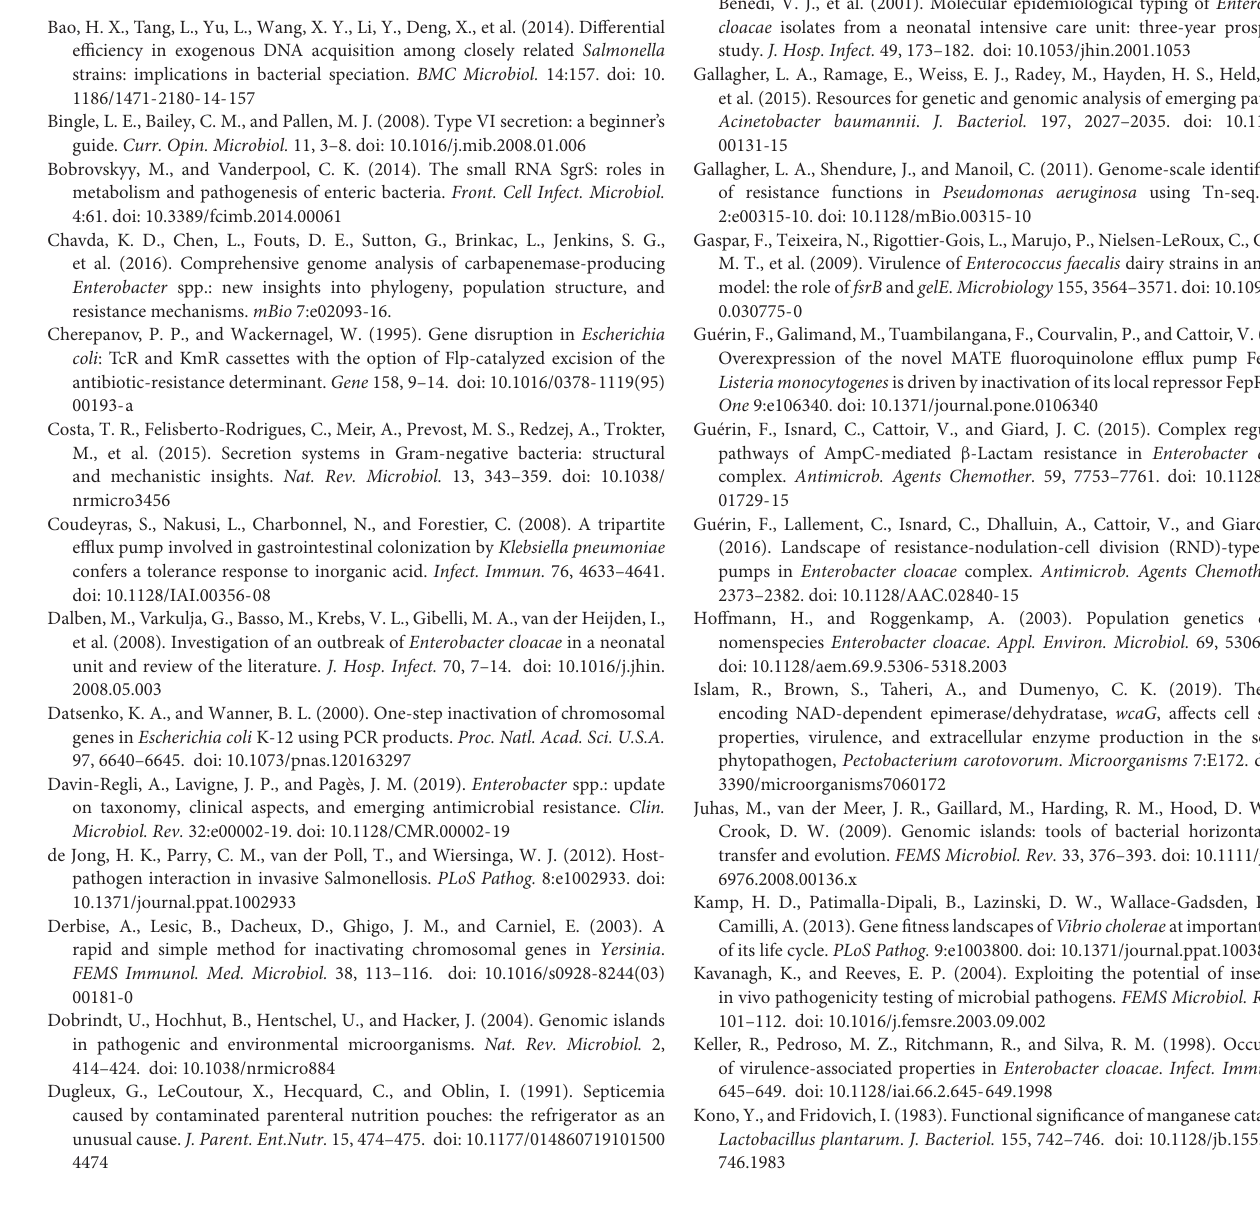
TABLE S3 | Genes identified as essential for growth in LB. TABLE S4 | Genes identified as essential for the survival within the larvae of G. mellonella . TABLE S5 | Genes of E. cloacae ATCC 13047 of which Tn mutants have been identified after growth in LB medium and/or after 48h in larvae of G. mellonella . TABLE S6 | Tn insertion mutants with a positive phenotype for larvae of G. mellonella colonization (changes > + 10-fold). TABLE S7 | Tn insertion mutants with a negative phenotype for larvae of G. mellonella colonization (changes < − 10-fold). TABLE S8 | Tn insertion mutants affected in genes with function is linked with